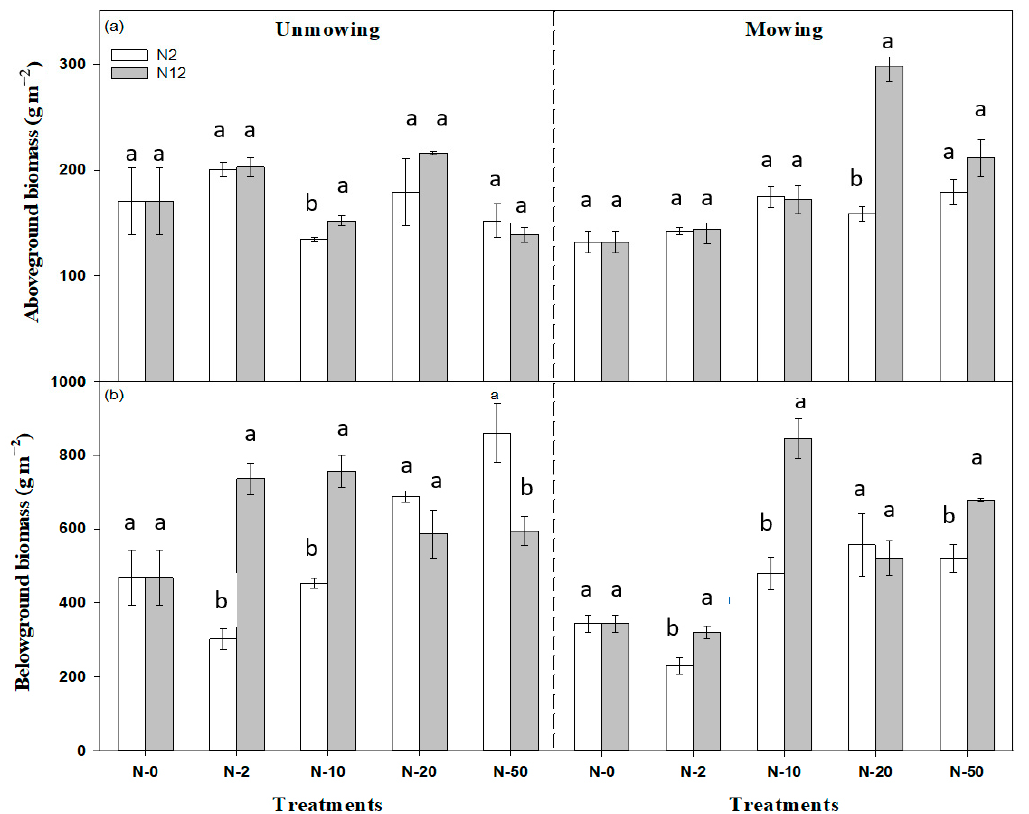
Figure 1. Responses of aboveground biomass ( a ) and belowground biomass ( b ) to N addition rate, N addition frequency, and mowing in the temperate steppe ecosystem studied. The data displayed are the means of four replicates ± standard errors (SE) of the mean. N2 and N12 represent 2 N additions yr − 1 and 12 N additions yr − 1 , respectively. Different lowercase letters represent groups that are significantly different at the p < 0.05 level (Tukey’s HSD test). Table 1. Results (F values) of repeated measures ANOVAs testing the effects of N addition rate (N), N addition frequency (F), and mowing (M) on soil pH, AGB, BGB, gross ammonification rates (GA), and gross nitrification rates (GN).